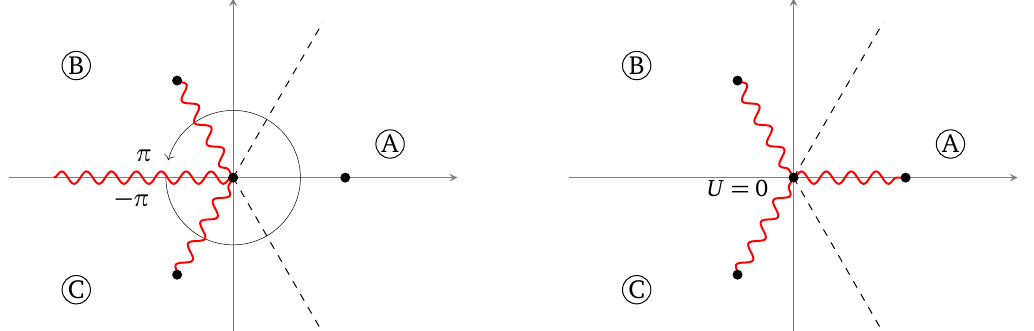
( U ) and a ( U ) of the E D